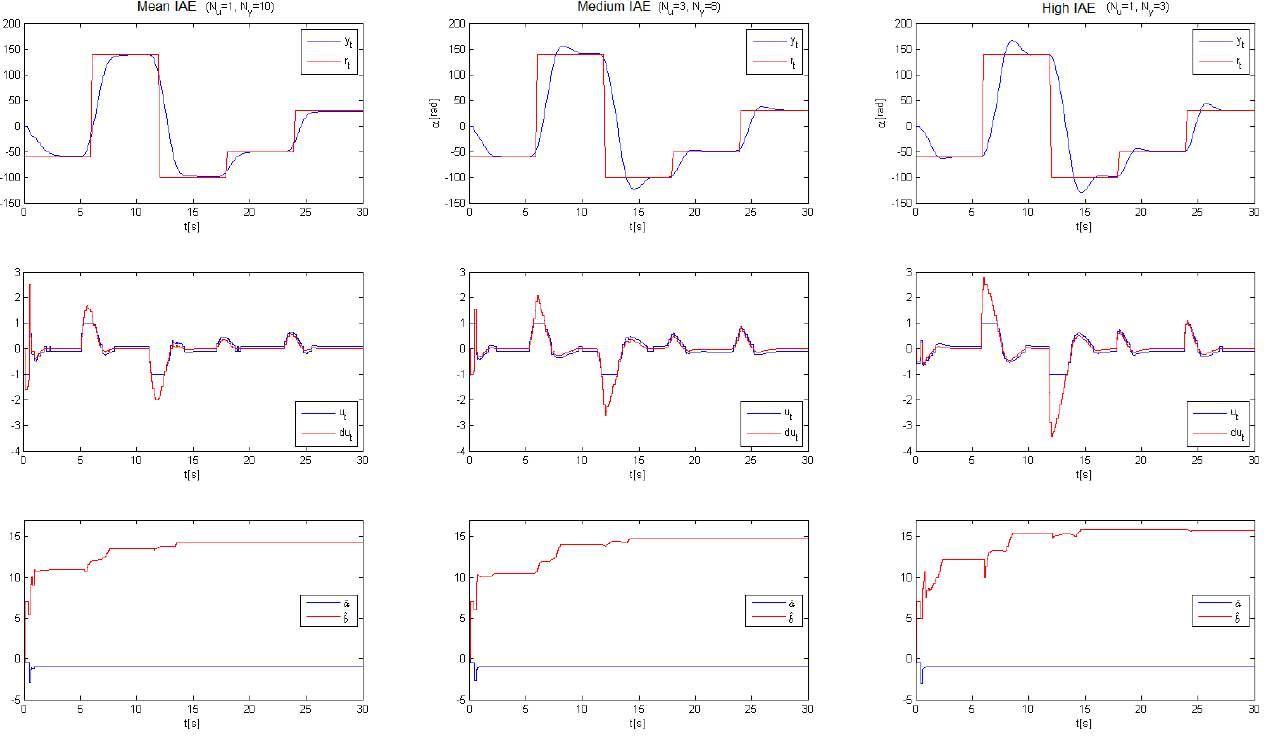
Figure 10. Selected experiments on the basis of integral of the absolute error (IAE) values, with q u = 3000, T S = 0.1